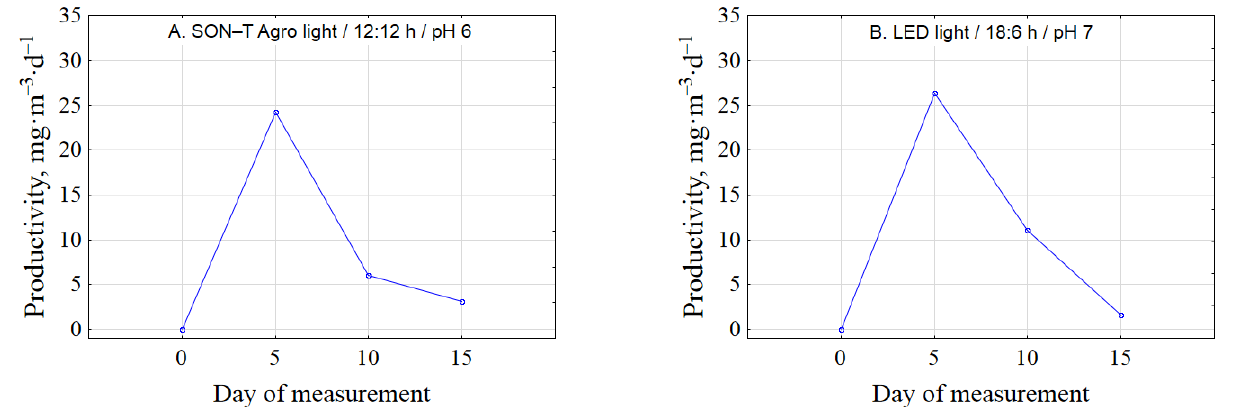
Figure 6. Chlorophyll productivity of C. vulgaris in SON-T Agro light ( A ) and LED light ( B ).